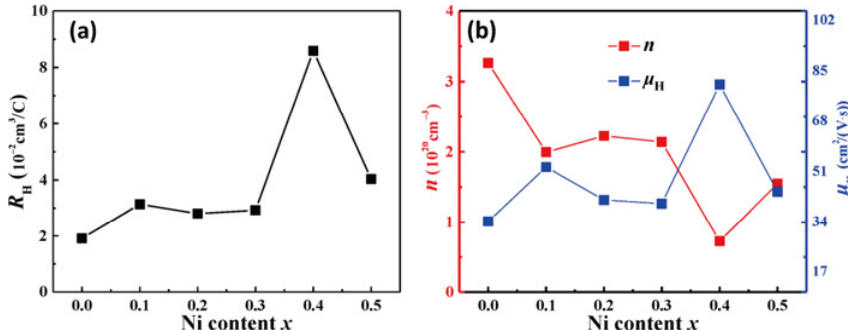
Fig. 6 (a) Hall coefficient ( R H ), (b) carrier concentration ( n ), and Hall mobility ( μ H ) as a function of Ni content